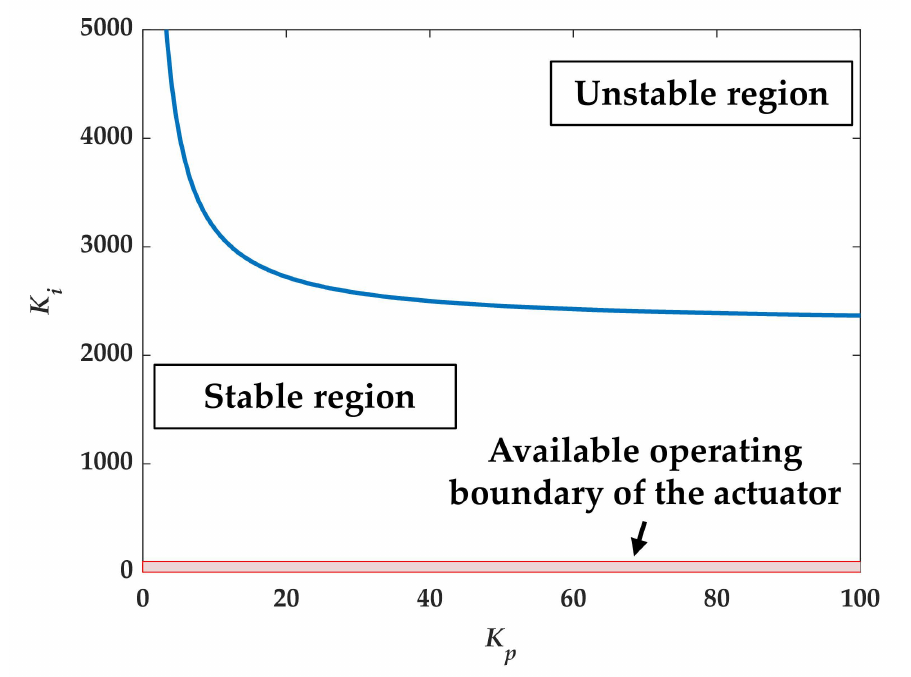
Figure 10. Stable range of K p and K i for the